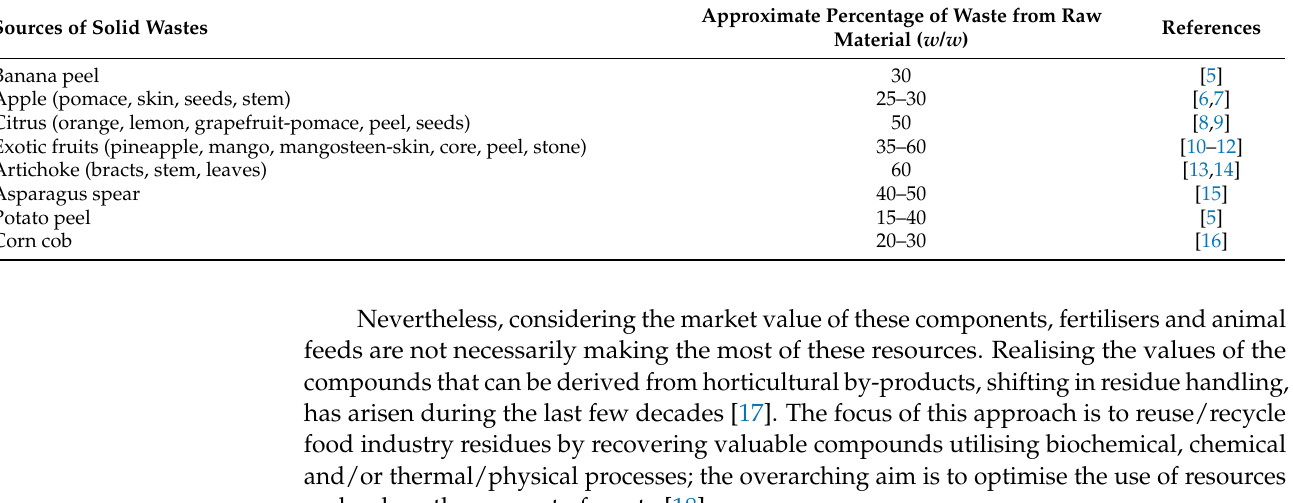
Table 1. Approximate percentages and nature of solid waste generated from fruit and vegetable manufacturing lines.